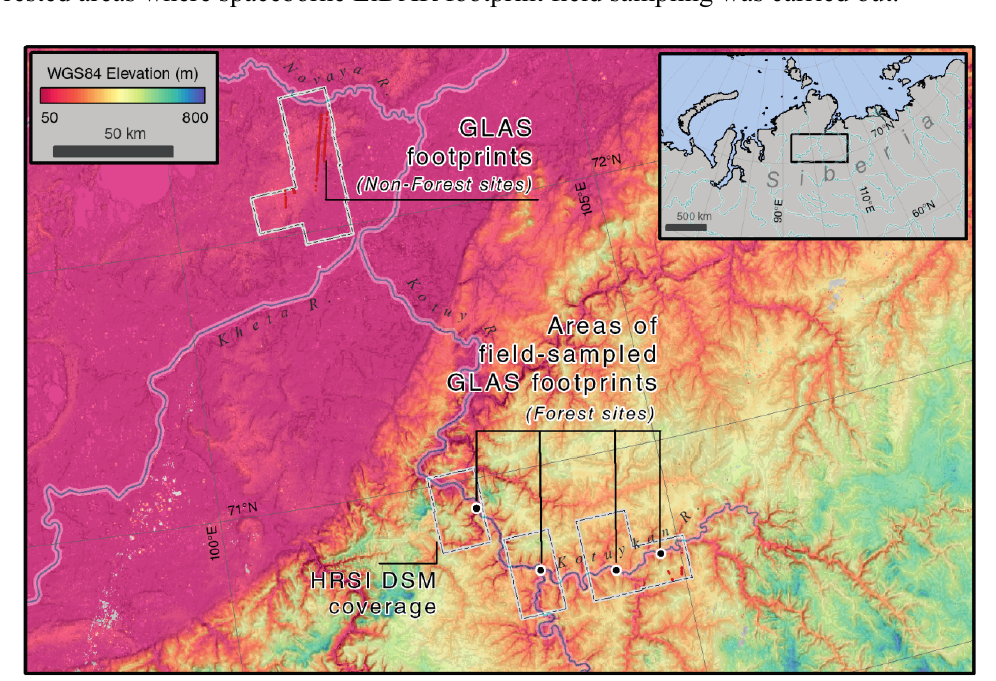
Figure 1. The northern Siberia study area showing the spatial coverage of Worldview-1 digital surface models, the spaceborne LiDAR footprints at non-forest sites, and the forested areas where spaceborne LiDAR footprint field sampling was carried